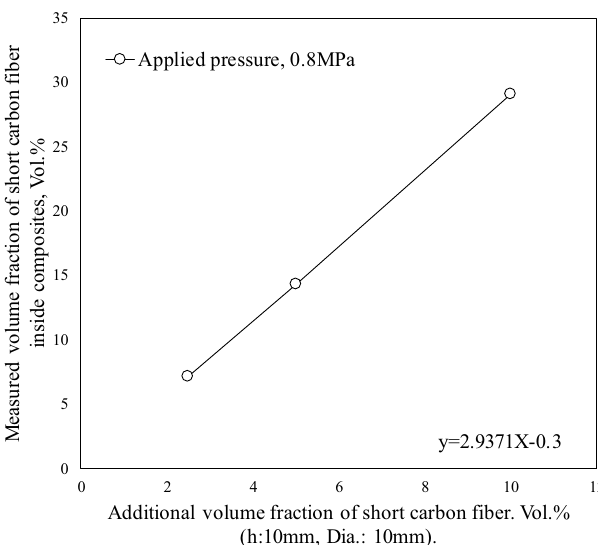
Figure 6. Relationship between additional volume fraction of short carbon fiber and measured volume fraction of short carbon fiber.